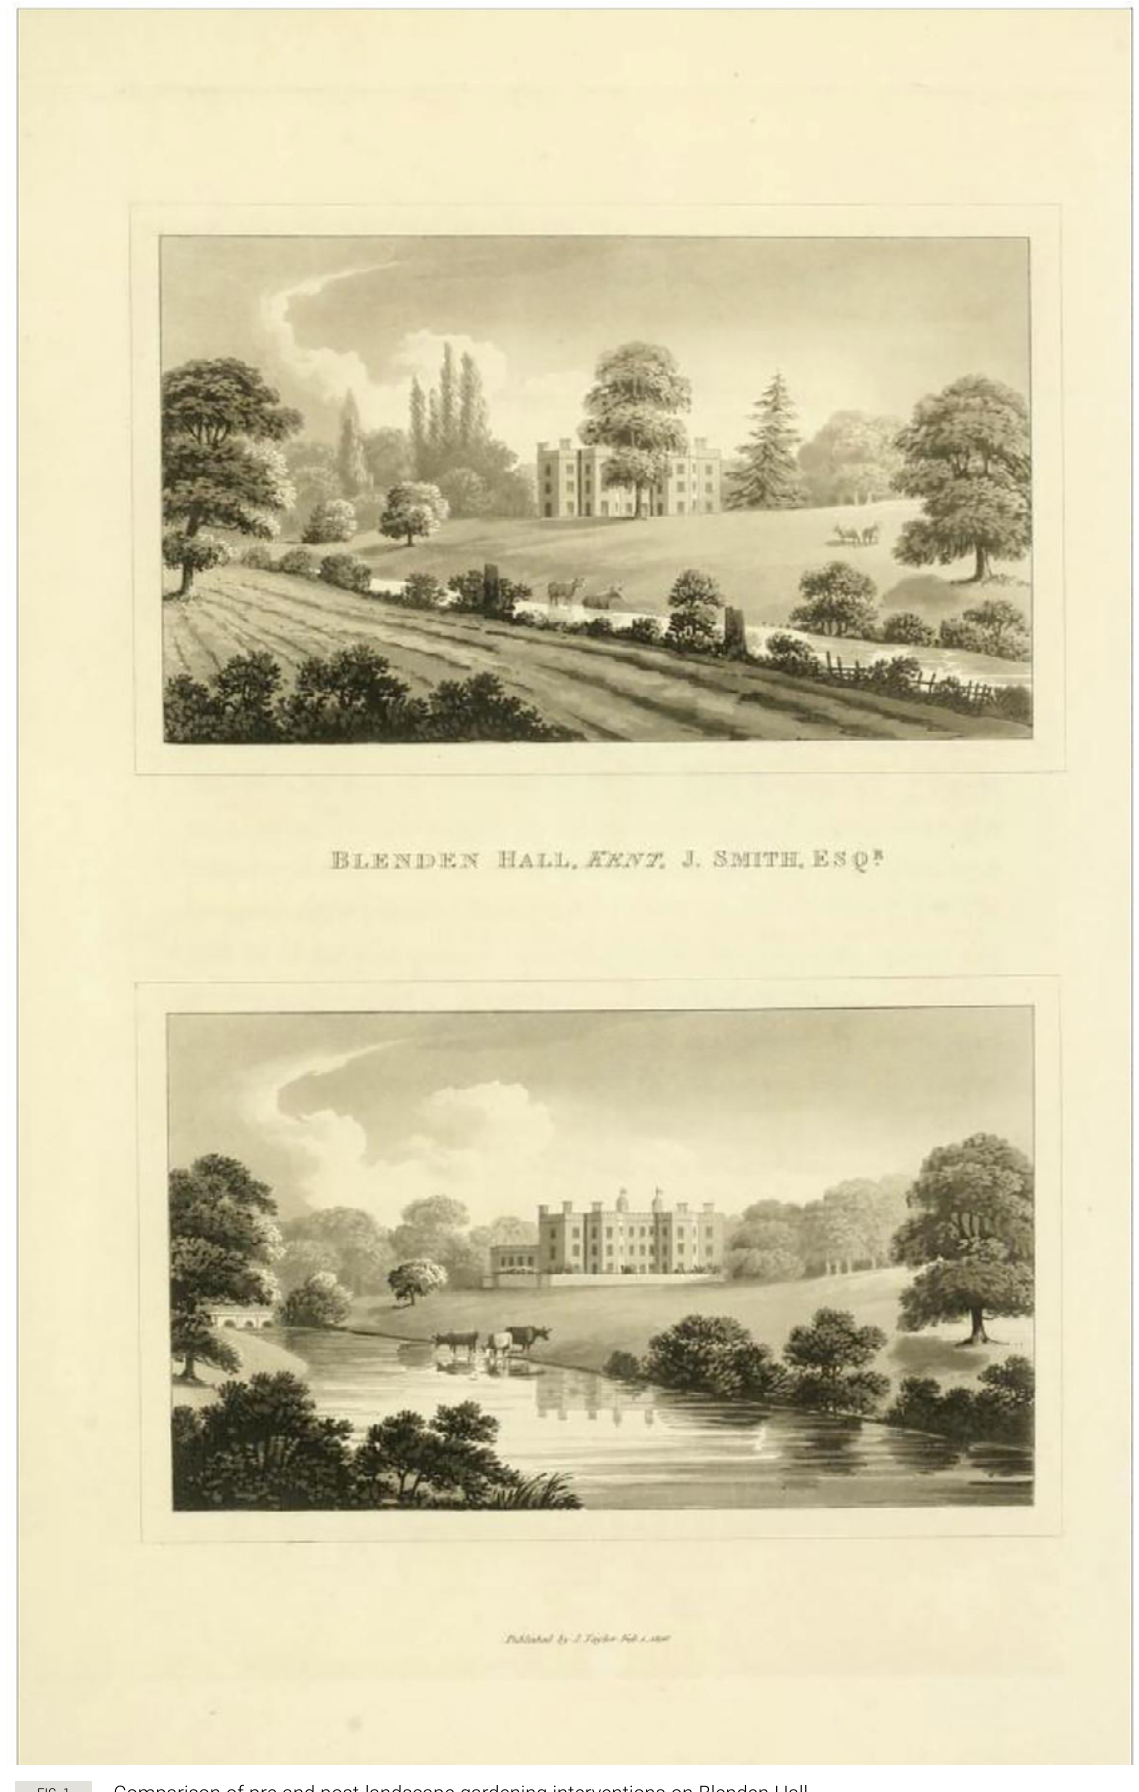
FIG. 1 Comparison of pre and post-landscape gardening interventions on Blenden Hall by Humphry Repton, 1816. Source: Internet Archive, San